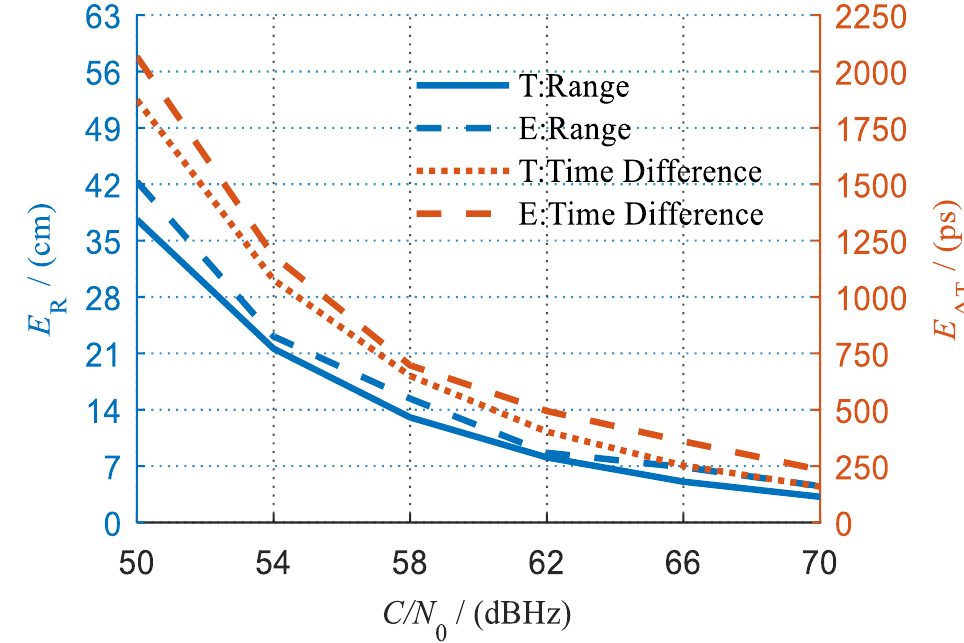
Figure 15. Experimental results (T means theory, E means experiment).